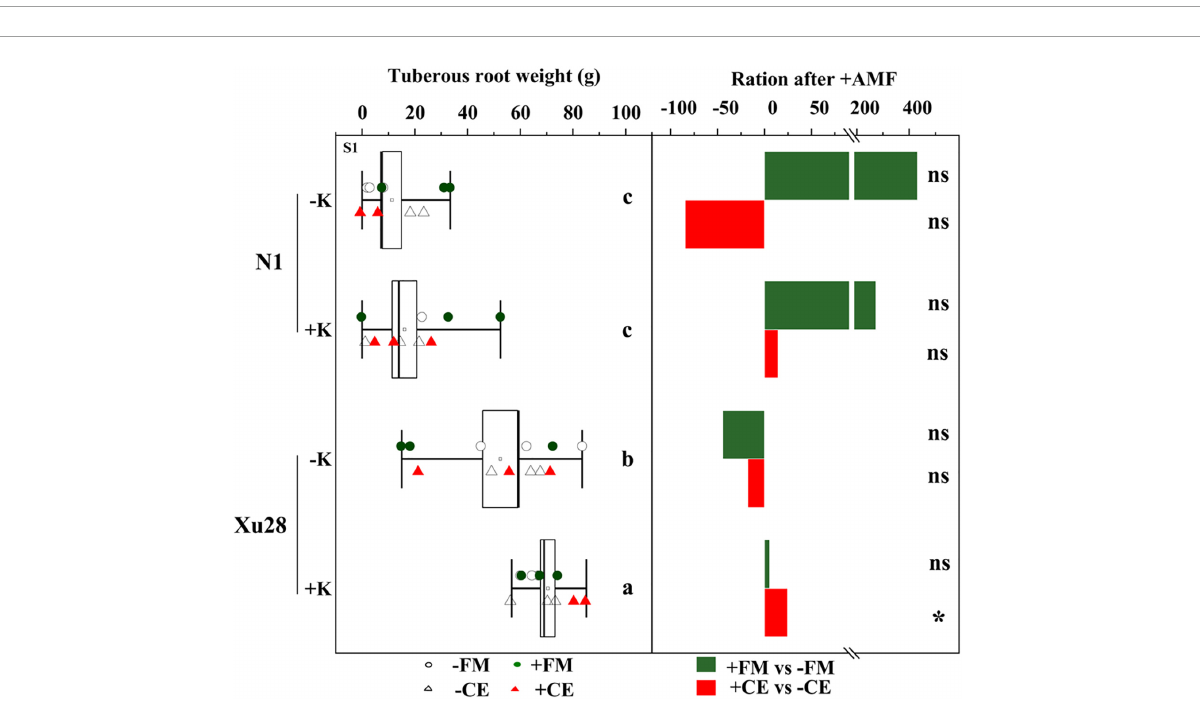
FIGURE2 The effects of arbuscular mycorrhizal fungi inoculation on tuberous root yield of sweet potato. Different lowercase letters indicate significant differences between different groups ( P < 0.05). Asterisks denote significant differences after arbuscular mycorrhizal fungi (AMF) inoculation ( t -test; * P < 0.05), while “ns” indicates nonsignificant